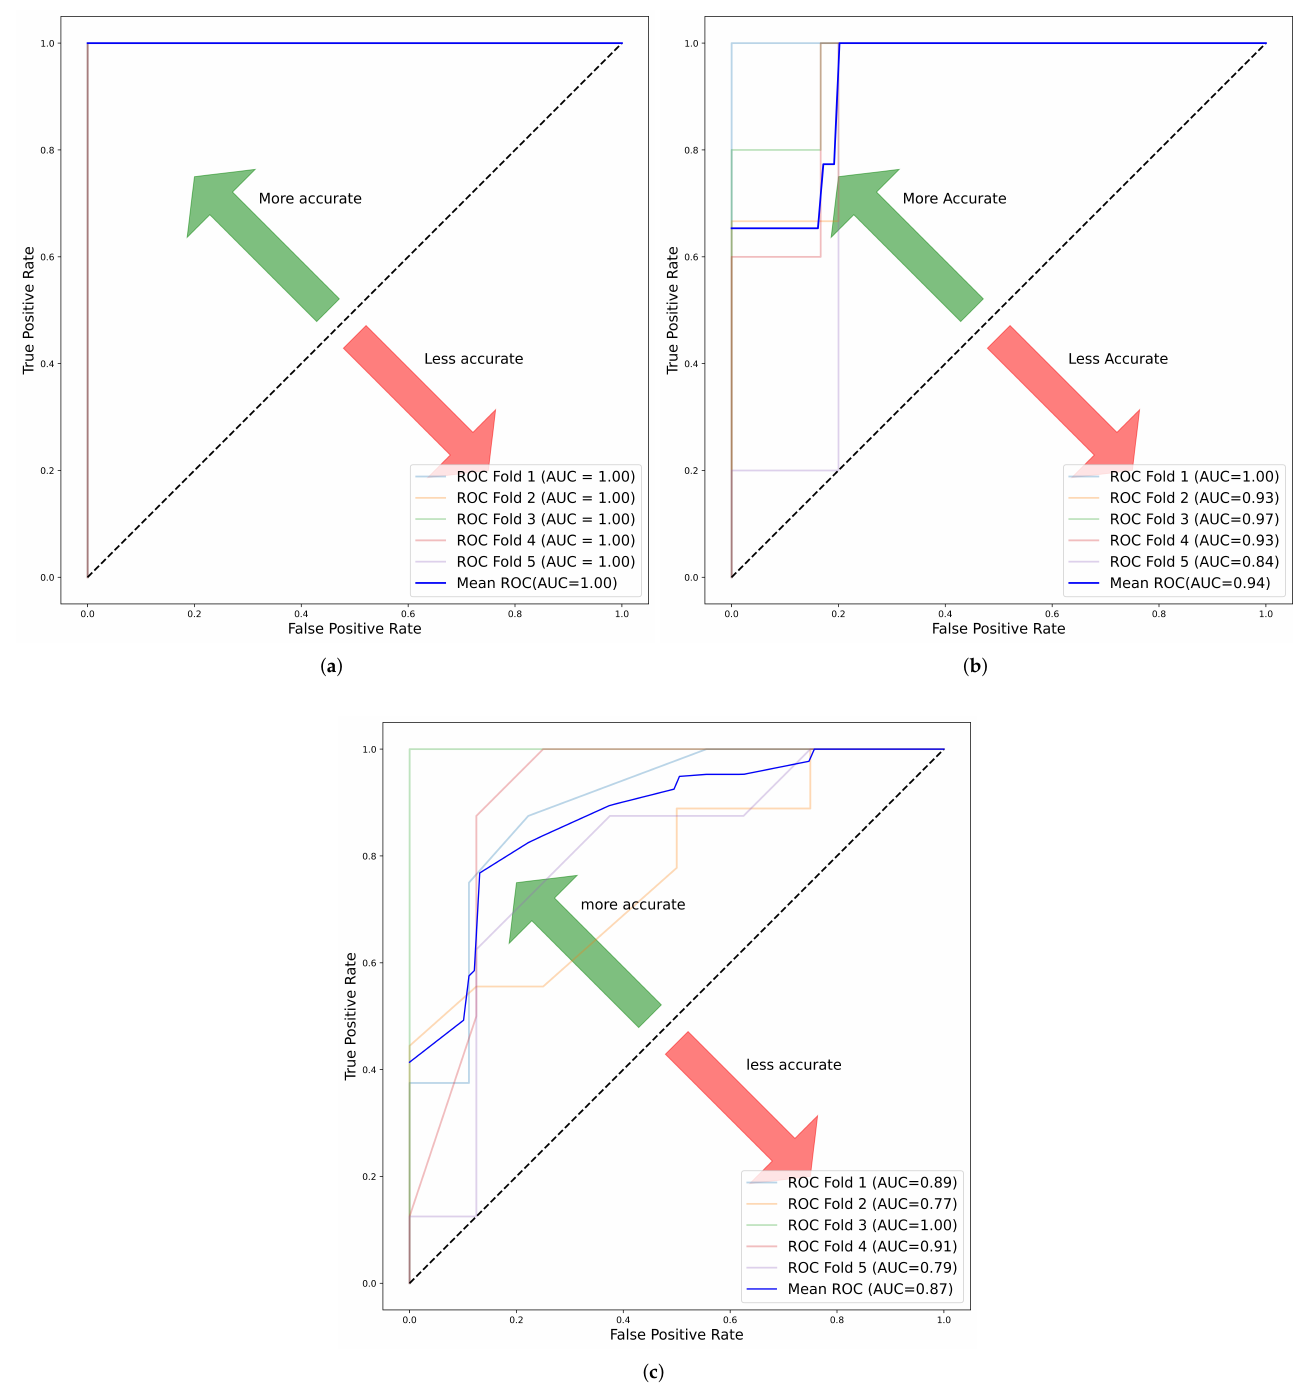
Figure A4. ( a ) ROC RF Whole Tumor Volume Filtered Cohort 1. ( b ) ROC SVM Whole Tumor Volume Filtered Cohort 2. ( c ) ROC KNN Whole Tumor Volume Filtered Combined